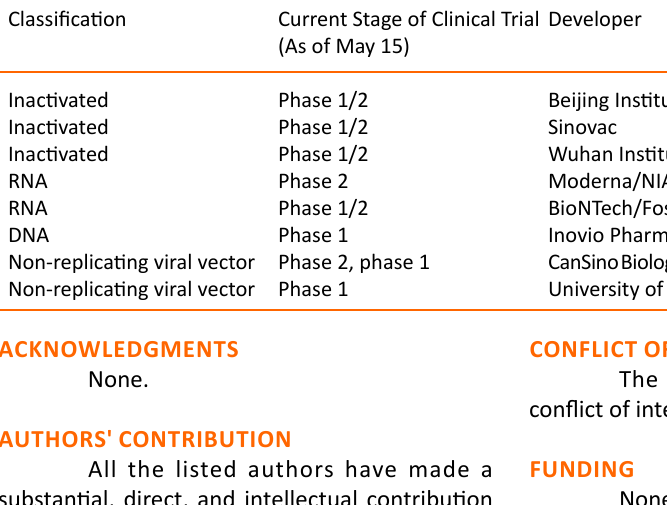
Table 2. Candidate vaccine currently under clinical evaluation